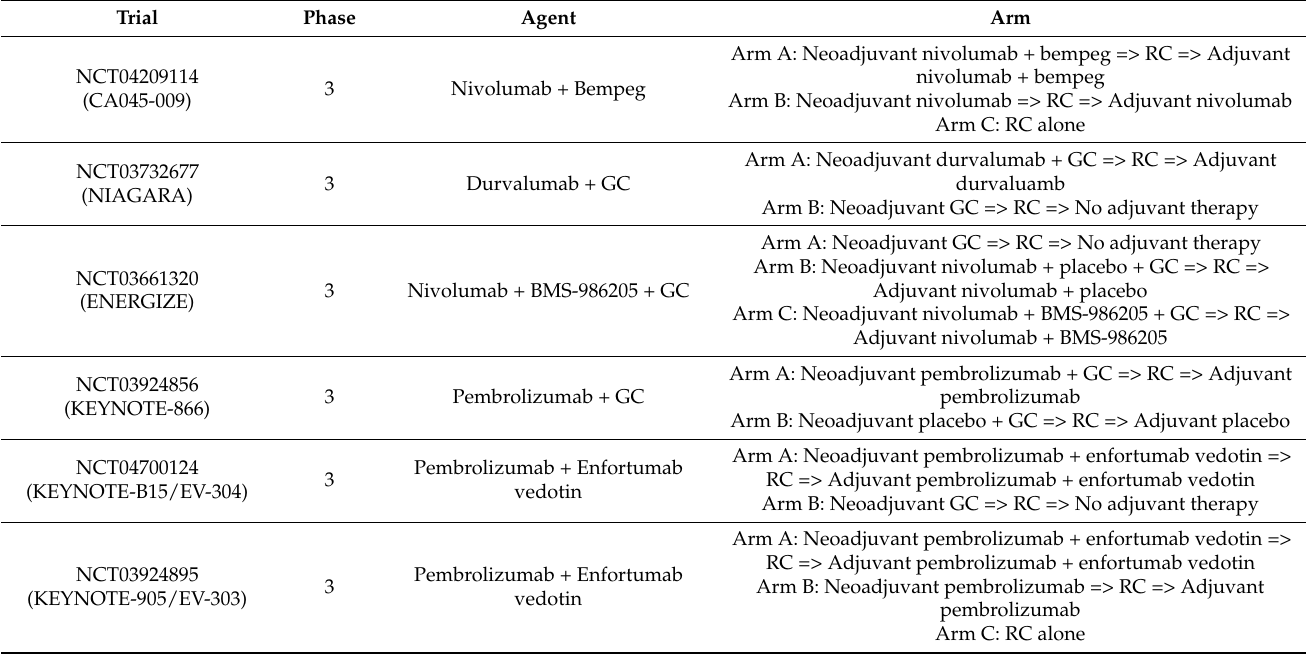
Table 6. Summary of phase 3 trials for perioperative sequential